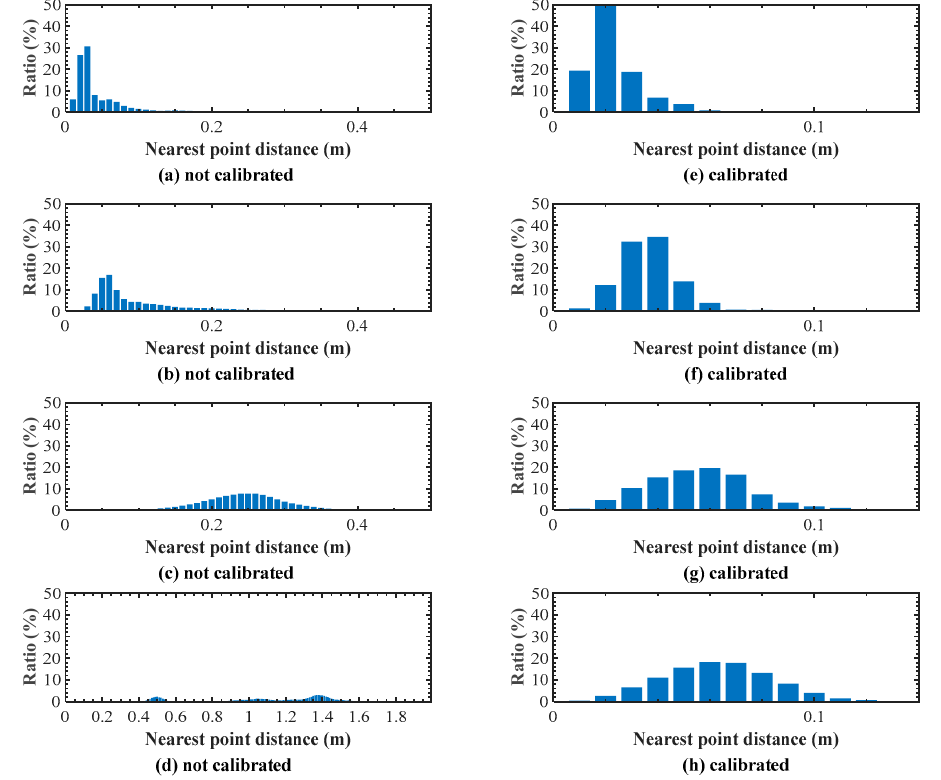
Figure 9. The histogram of distances between point correspondences. ( a – d ) are the histogram of distances of “MLS1”, “MLS2”, “ULS1” and “ULS2” before boresight angle calibration. ( e – h ) are the histogram of distances of “MLS1”, “MLS2”, “ULS1” and “ULS2” after boresight angle calibration.